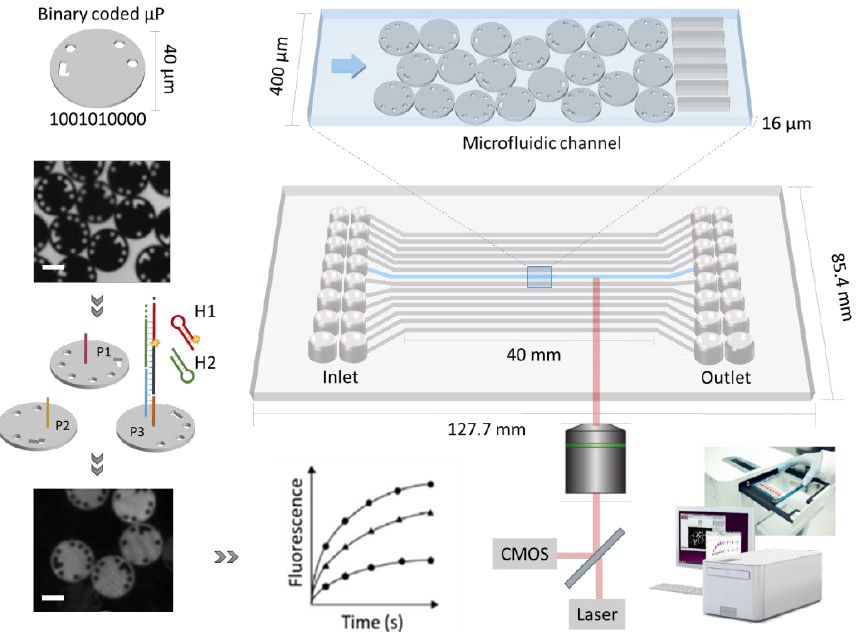
Figure 1. Schematic representation of the components of the Evalution ™ technology, including digitally barcoded microparticles, microfluidic cartridge and an integrated instrument. Each microfluidic channel is embedded with encoded microparticles (P1, P2 and P3) that each serve as the substrate for the detection of a specific target. In presence of target, the hybridization chain reaction is initiated and the microparticles are identified during signal read-out. Based on bright field imaging, the microparticle populations are decoded and fluorescence imaging is used to quantify the signal. The scale bar represents 20 µm.